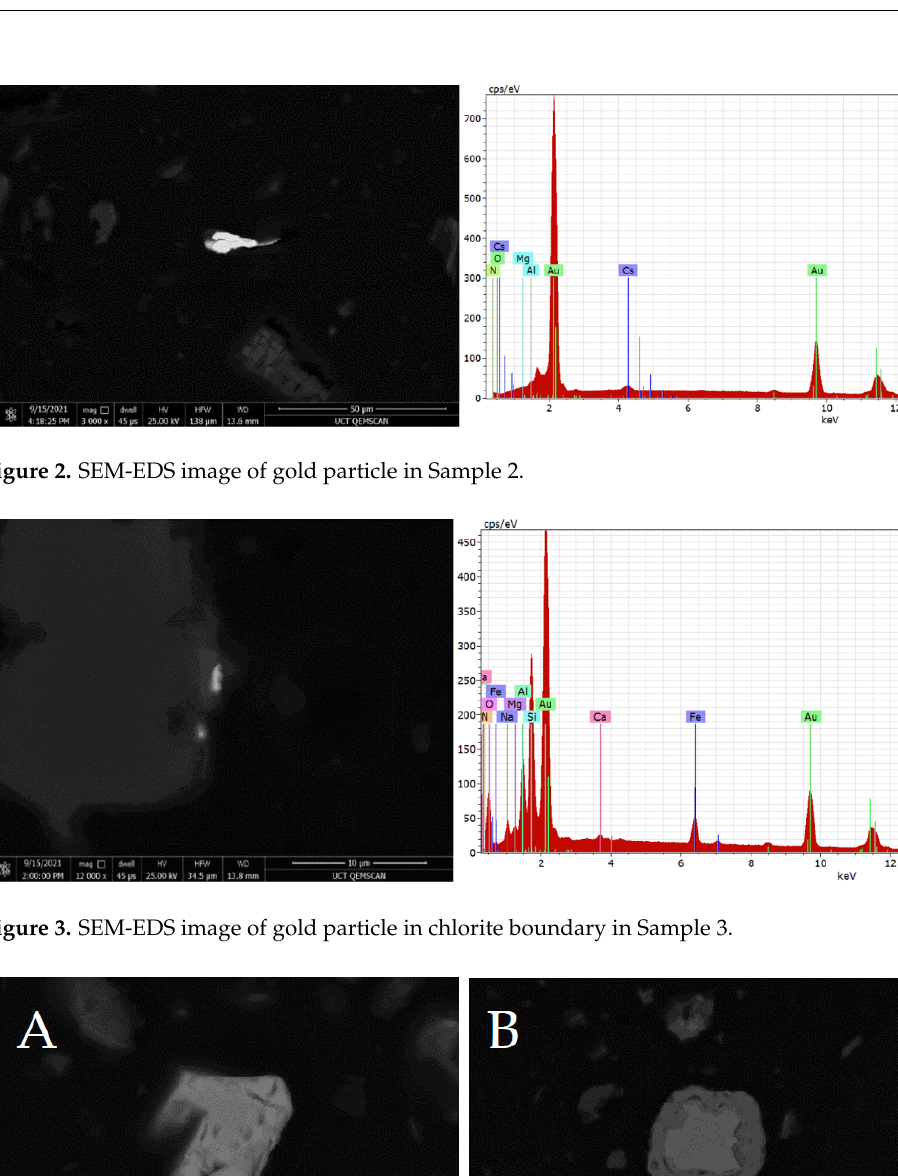
Figure 1. SEM-EDS image of gold particle in Sample 1.